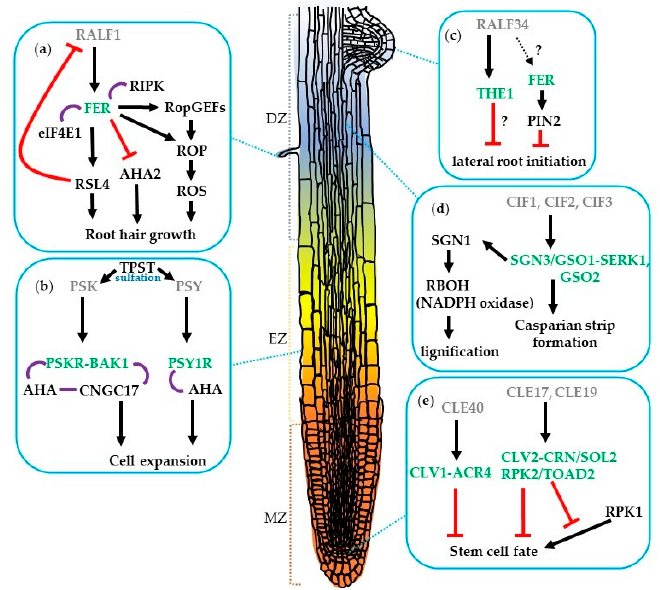
Figure 1. Regulation of root development by ( a , c ) RALF, ( b ) PSK and PSY, ( d ) CIF, and ( e ) CLE peptide signaling pathways. The small peptides (grey) and their receptors (green) involved in lateral root initiation, Casparian strip formation, root hair growth, root cell expansion, and root stem cell fate in Arabidopsis . Arrows indicate positive regulation; red bars show negative regulation; purple lines represent association; and question marks indicate unknown mechanism. MZ, meristematic zone; EZ, elongation zone; DZ, differentiation zone.